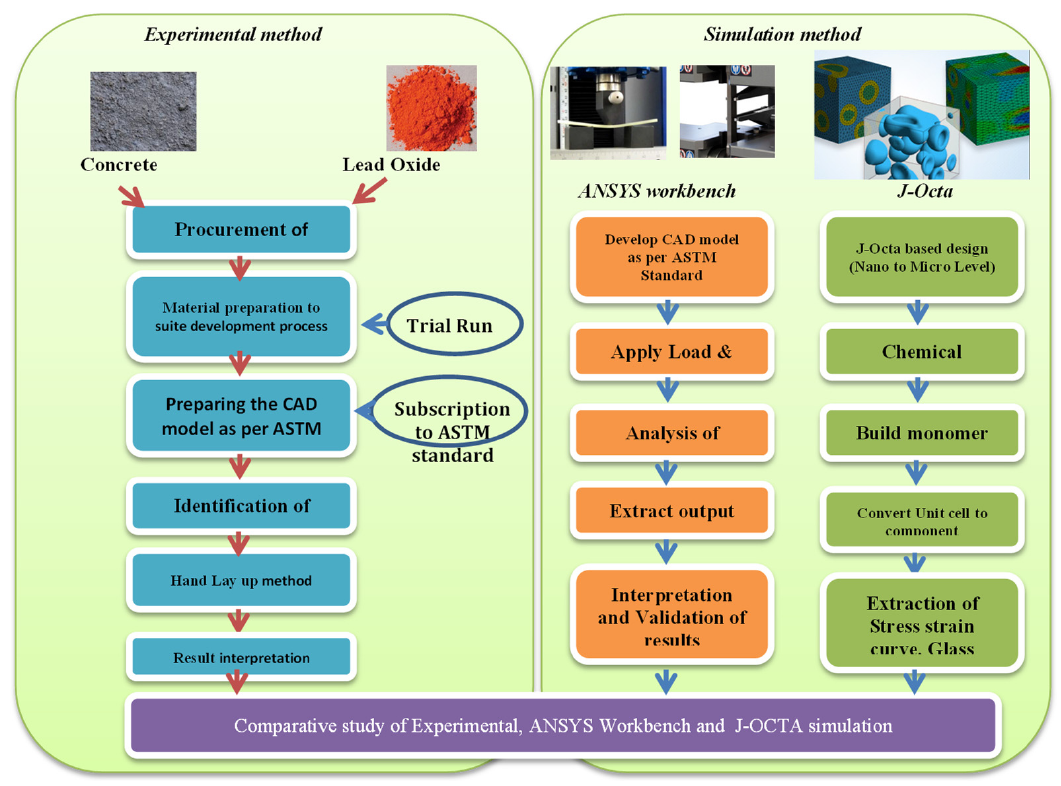
Figure 9. Process map for simulation in experimental work.